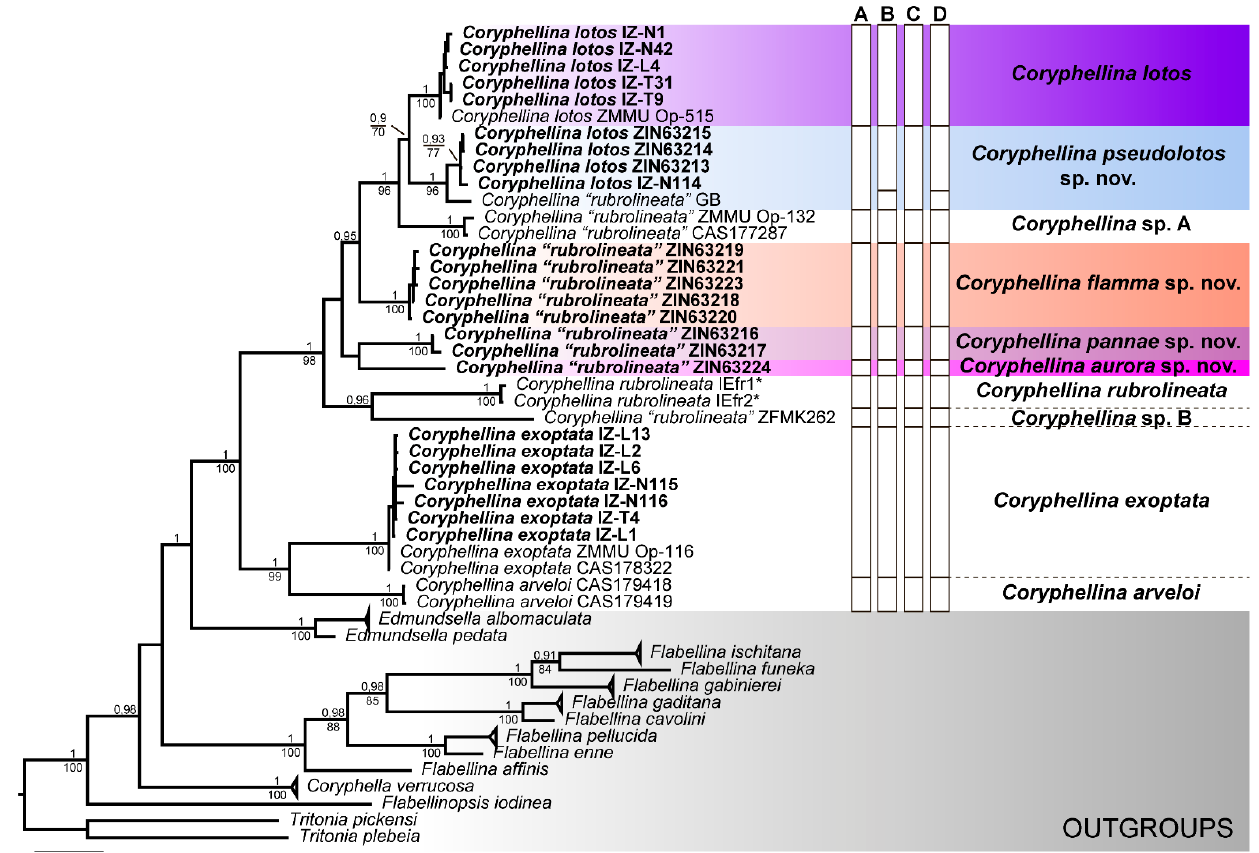
Figure 2. The Bayesian phylogenetic tree of the genus Coryphellina based on the concatenated data set of four markers (COI+16S+H3+28S). Specimens in bold are studied in this work. The taxa labels on the tree indicate the initial identification of the specimens, and species names on the right indicate the revised species hypothesis. White blocks correspond to results of species delimitation analyses: ( A )—ASAP ( p = 1.06, score 1.5); ( B )—ASAP ( p = 2.12, score 1.5); ( C )—bPTP; ( D )—GMYC. Numbers above branches indicate posterior probabilities of the Bayesian inference, numbers below—bootstrap support from the maximum likelihood. A star (*) indicates the nominative species Coryphellina rubrolineata, collected near the type locality.